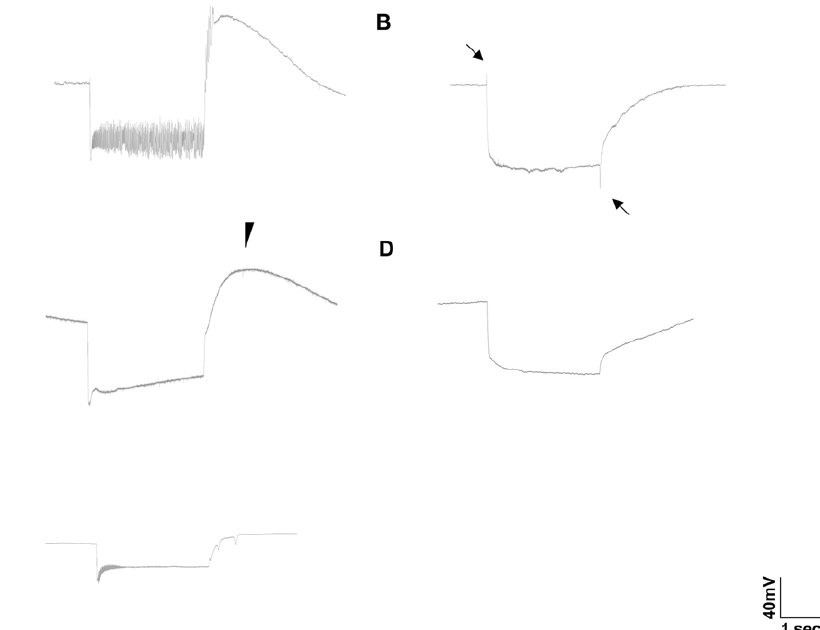
Figure 5. Thioperamide and Immepip Treatment Rescues Oscillations in ine 2 ERGs and Ablates Transients in w 1118 Flies ERG recordings from untreated (A) ine 2 and (B) w 1118 and 0.5% thioperamide-treated (C) ine 2 and (D) w 1118 , and (E) 0.5% immepip-treated ine 2 flies. Note that while ERG recordings from untreated ine 2 mutants display oscillations and a hyperpolarization response, treatment of ine 2 flies overnight with 0.5% thioperamide results in a loss of oscillations and on and off transients but not the hyperpolarization response (arrowhead). (E) Treatment of ine 2 flies overnight with 0.5% immepip results in a loss of oscillations and hyperpolarization response in . 50% of ine 2 mutants